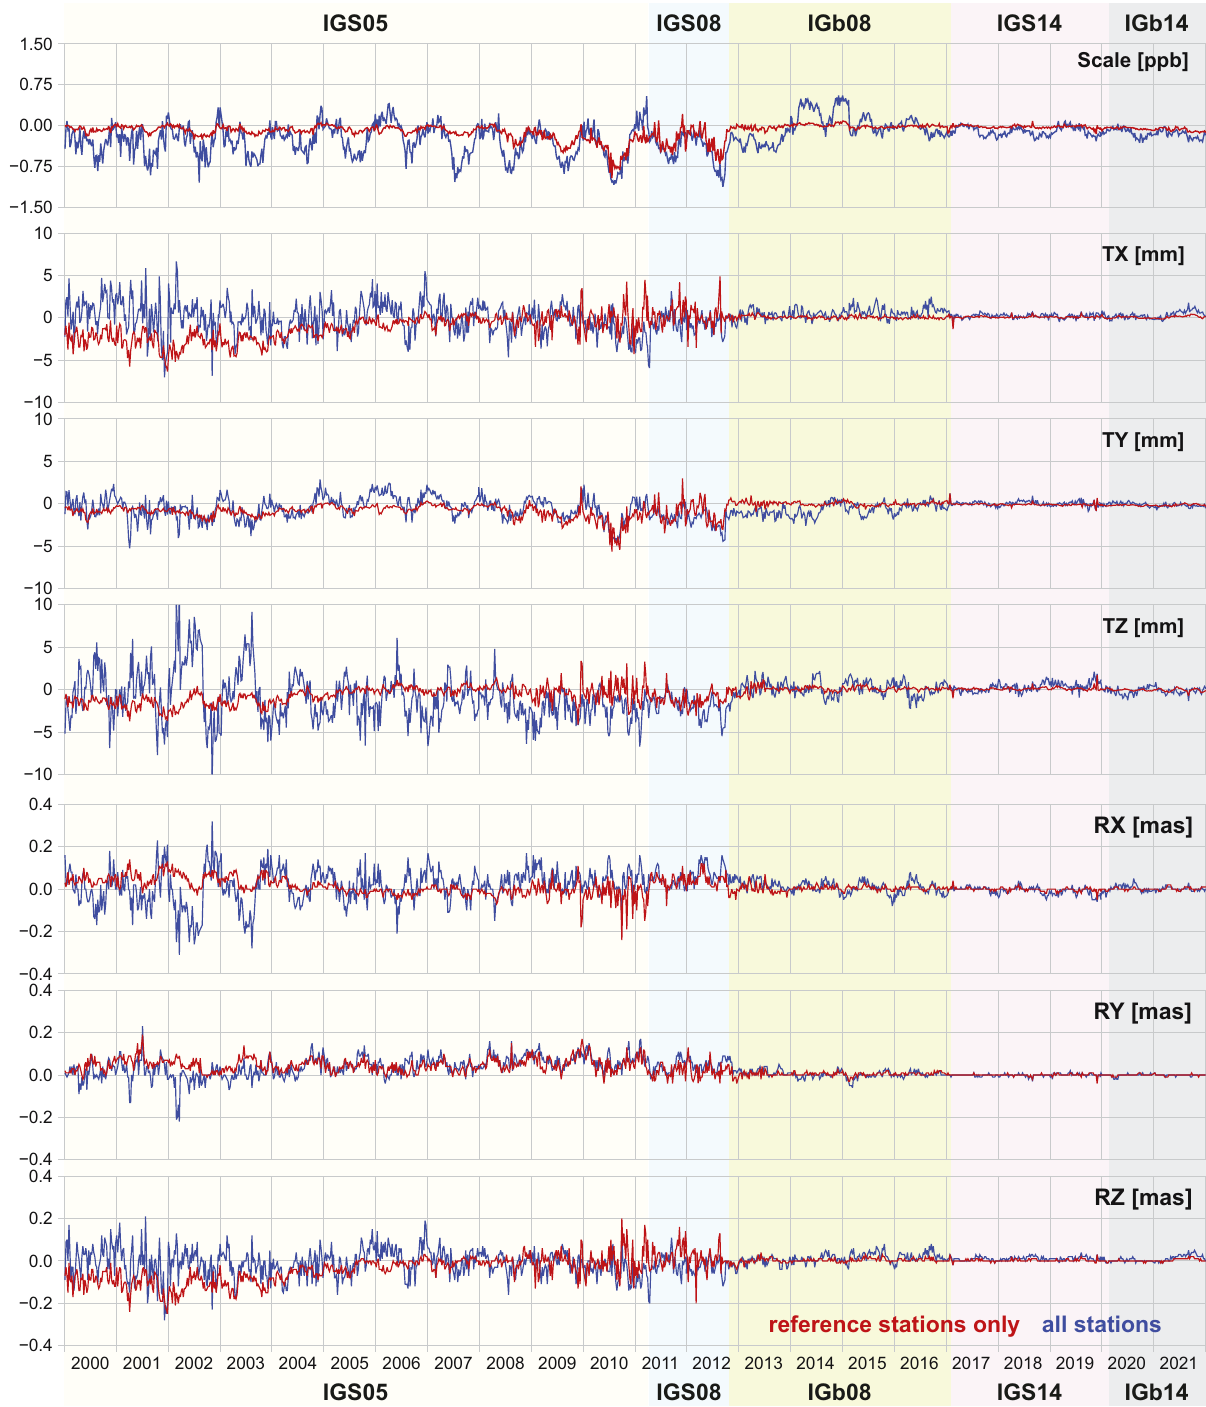
Figure 7: Di ff erences in scale, translation, and rotation parameters between the SIRGAS and IGS weekly position solutions. Red lines represent parameters determined using fi ducial stations only, while blue lines represent the values obtained when using all SIRGAS/IGS common stations. Background colours indicate the IGS reference frame in